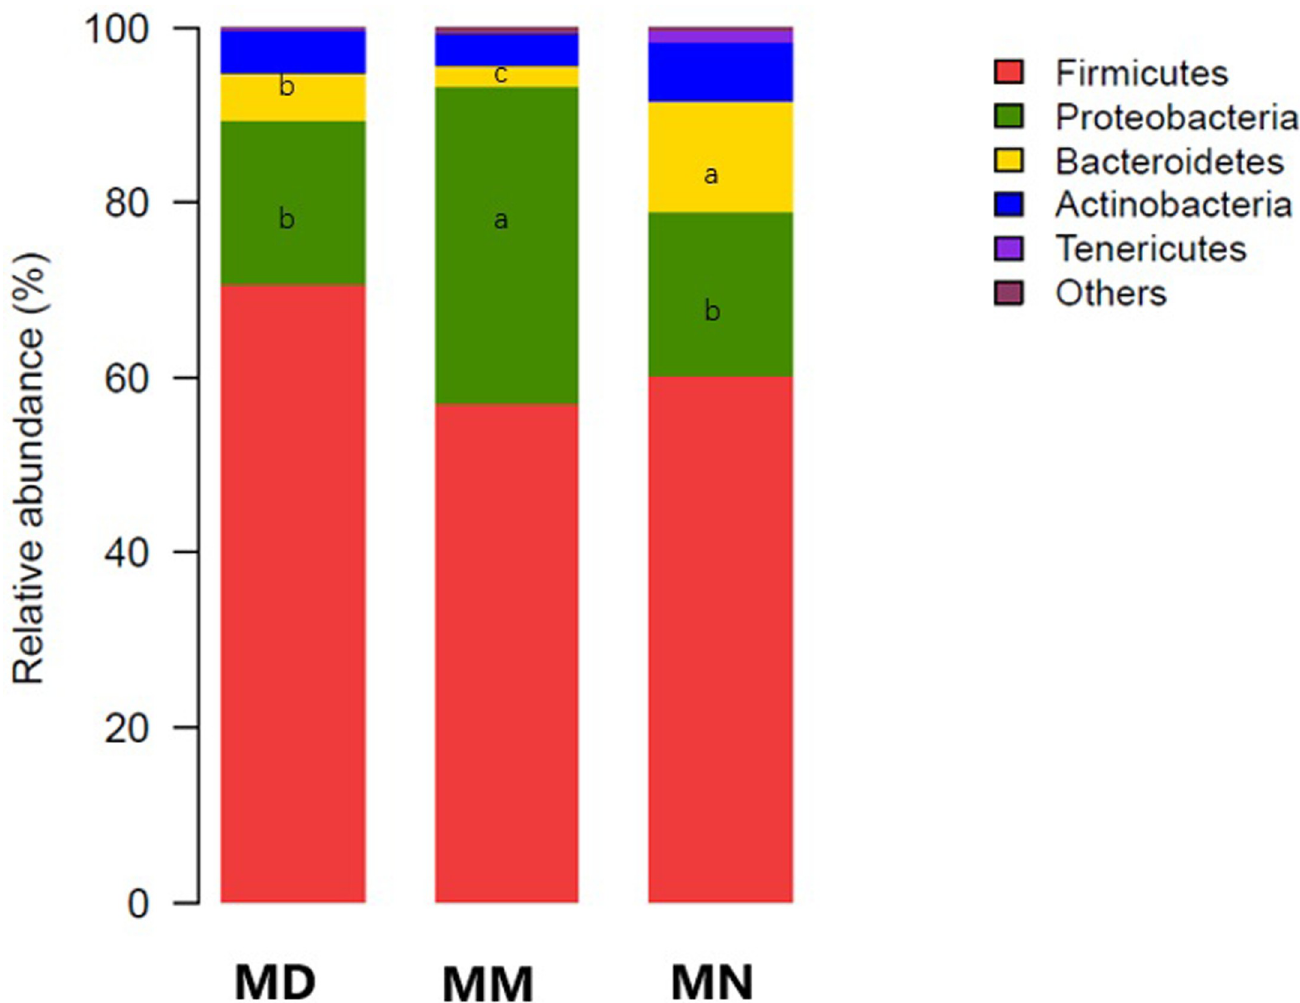
Fig 4. Bacterial distribution at the phylum level. Bacterial distribution based on the phylum taxonomical level in the normal group (MN), the model group (MM) and the treatment group (MD). Different lowercase letters indicated significant difference( P < 0.05).